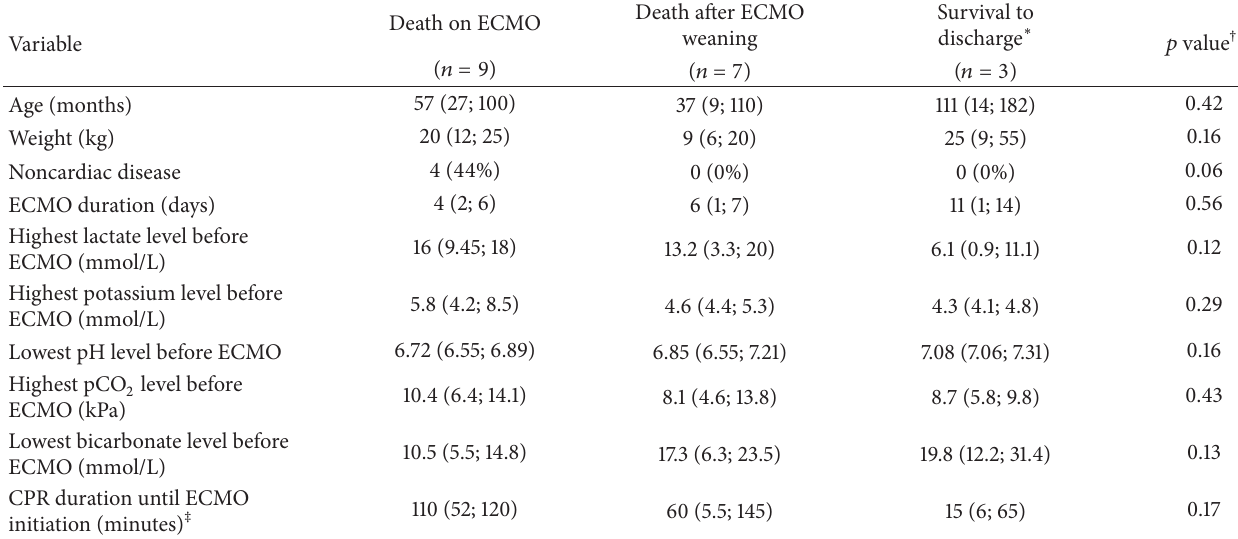
Table 1: Demographic data, laboratory tests before ECMO initiation, and CPR duration, according to survival